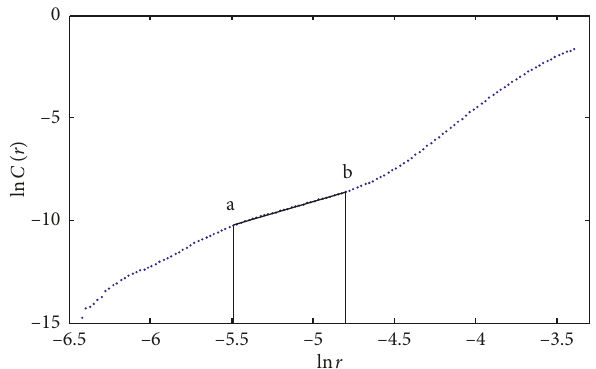
Figure 9: ln r ∼ ln C